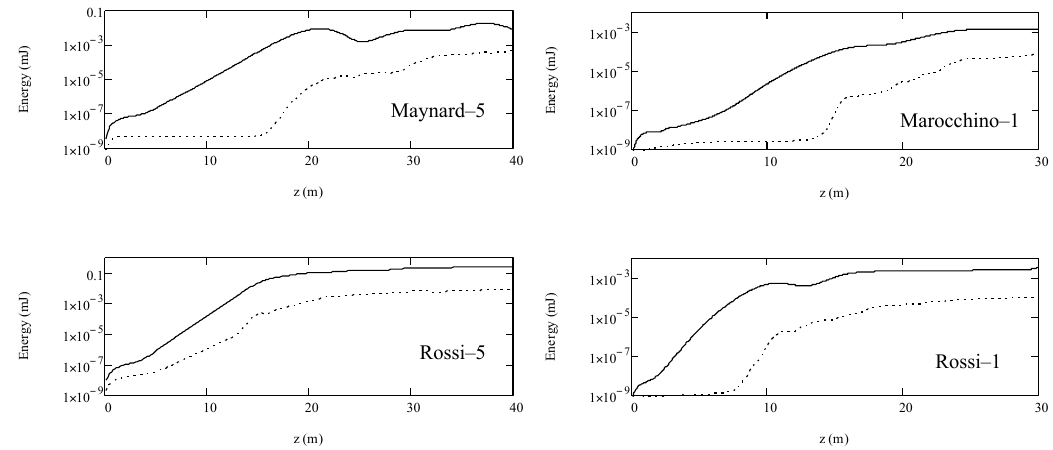
Figure 6. Growth of the self-amplified spontaneous emission (SASE) FEL energy per pulse of the specified beam distributions, for the fundamental (solid line) and third (dotted line) harmonic.